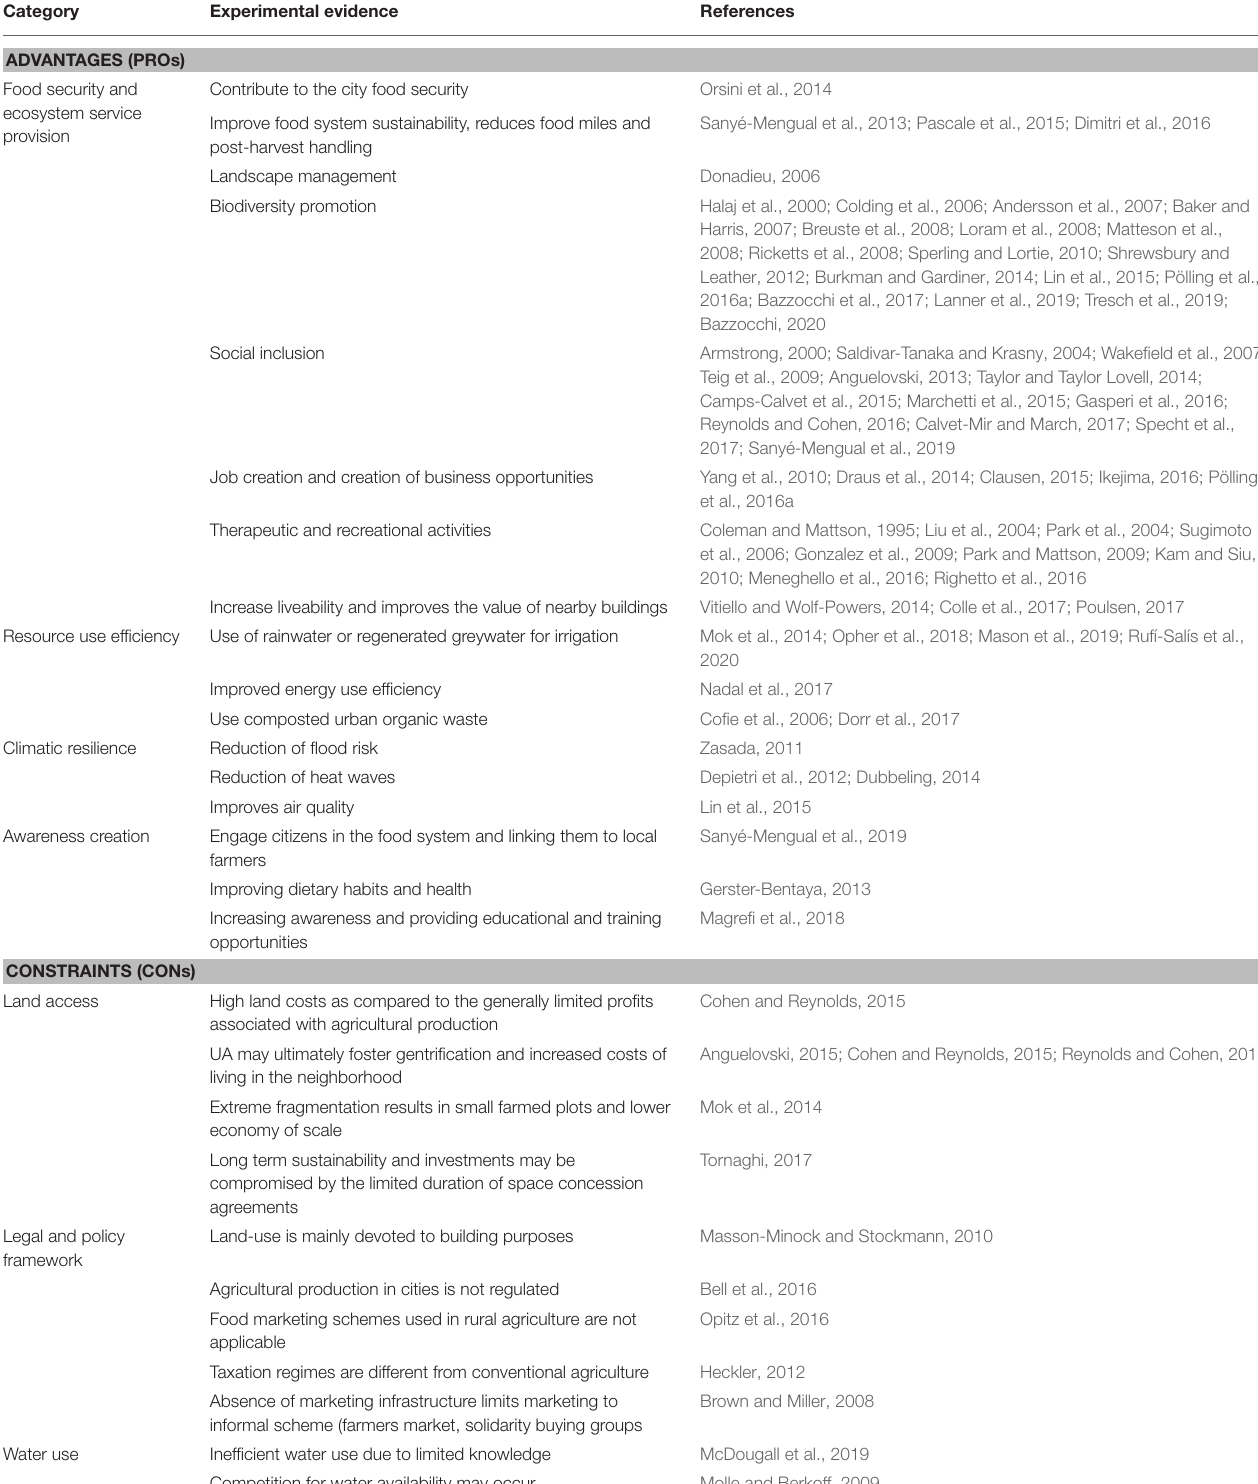
TABLE 1 | PROs and CONs of Urban